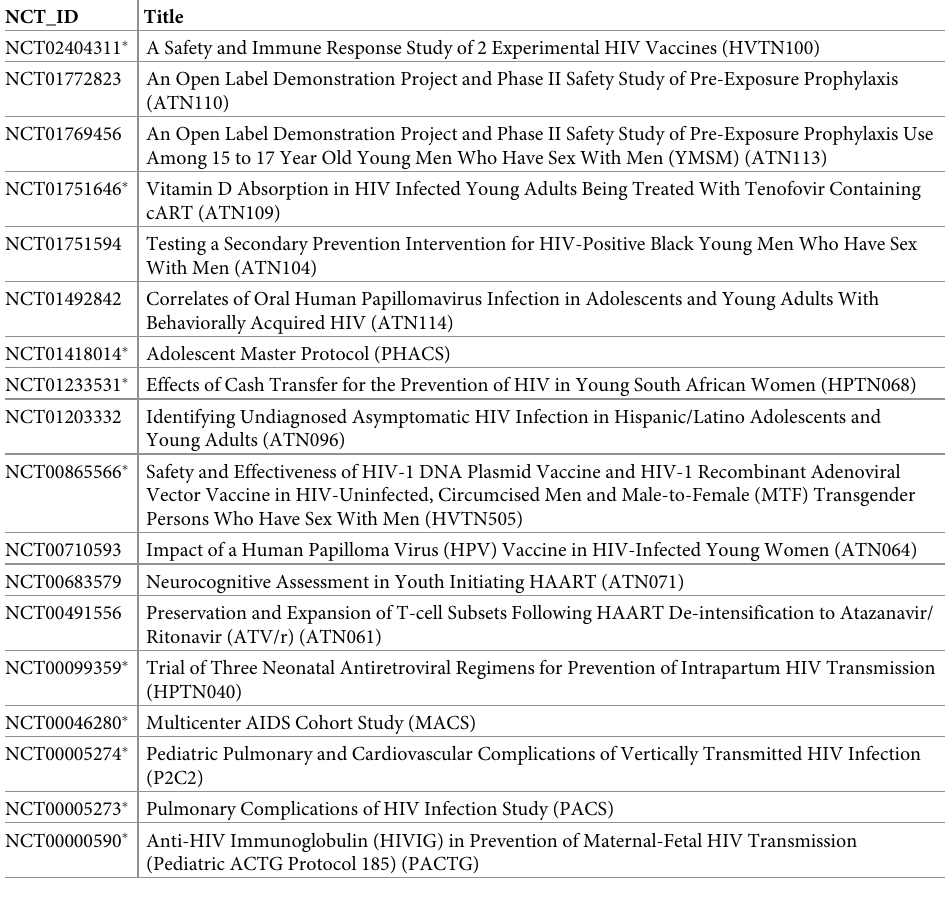
Table 3. List of 18 HIV trials in the final set analyzed for data